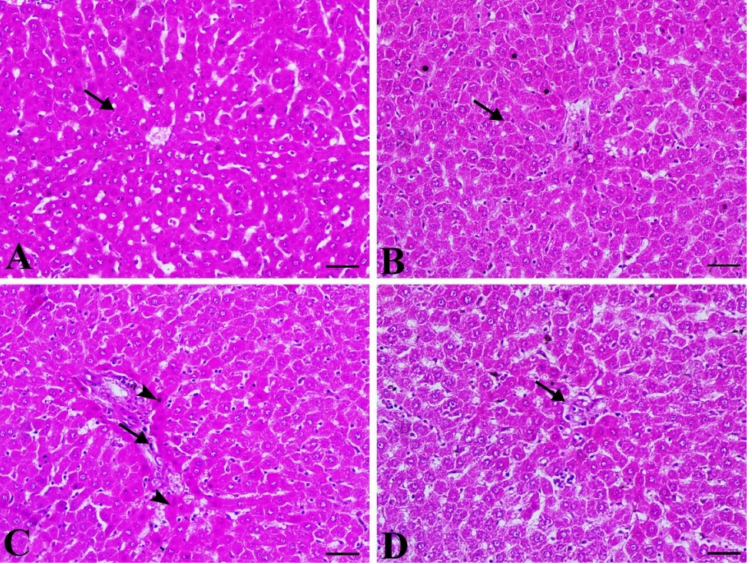
Figure 4. Photomicrographs of sections in the liver of ( A ) control rats showing normal hepatocytes and central vein (arrow), ( B ) galangin-supplemented rats showing normal hepatic tissues (arrow), ( C ) diabetic rats showing periportal apoptosis of the hepatic cells associated with fibroblastic cells proliferation (arrow), and ( D ) diabetic rats treated with galangin showing mild degree of periportal apoptosis with scanty fibroblastic activity (arrow). (H&E, Scale bar = 50 µ